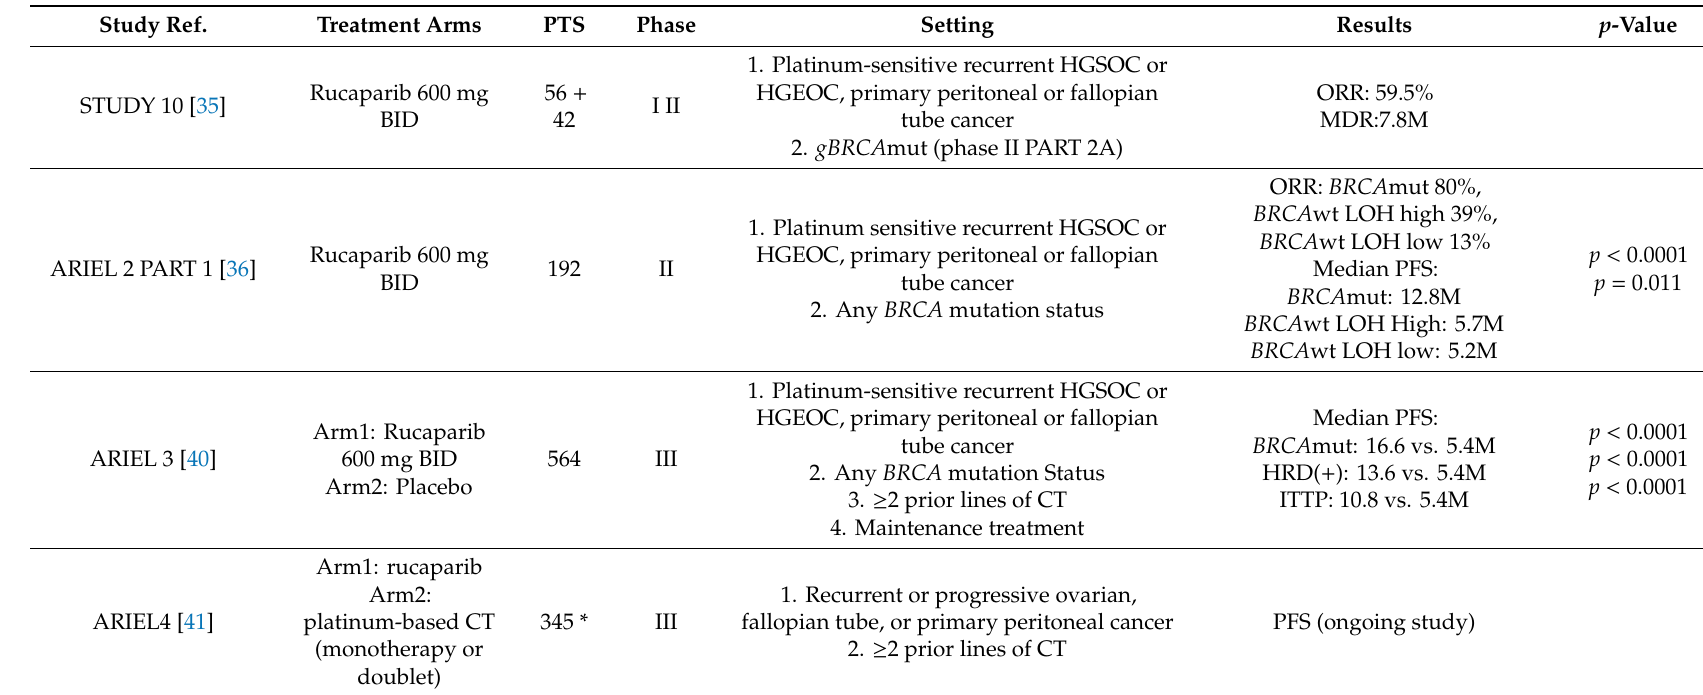
Table 3. Clinical trials results for Rucaparibin in ovarian